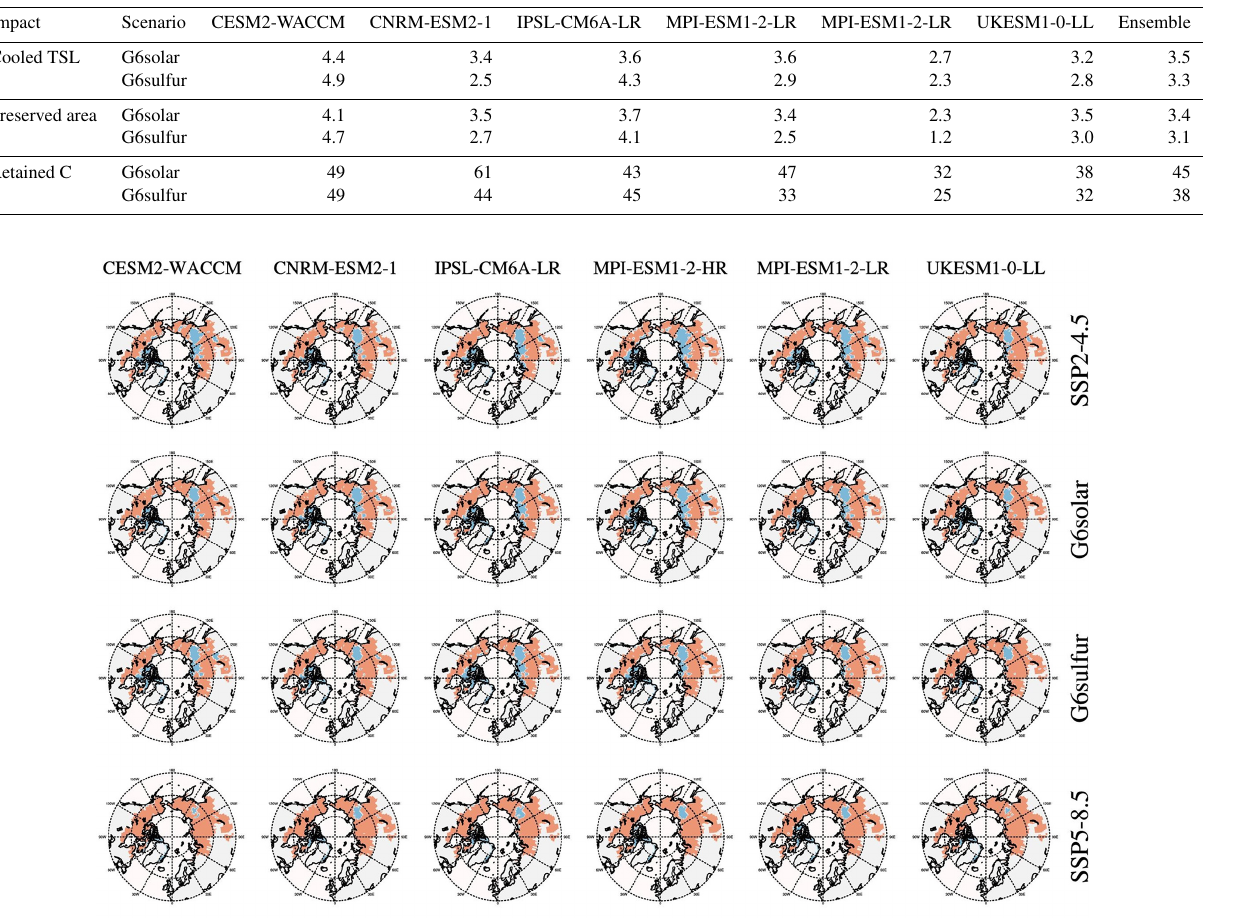
Table 3. G6 impacts on soil temperatures, permafrost degradation, and soil C storage . Cooled soil temperature ( ◦ C), preserved permafrost area (millions of square kilometres), and retained permafrost soil C (Pg) at the end of the century for the G6solar and G6sulfur scenarios relative to the SSP5-8.5 scenario. All values are significant at the 95% level according to the Wilcoxon signed-rank test.